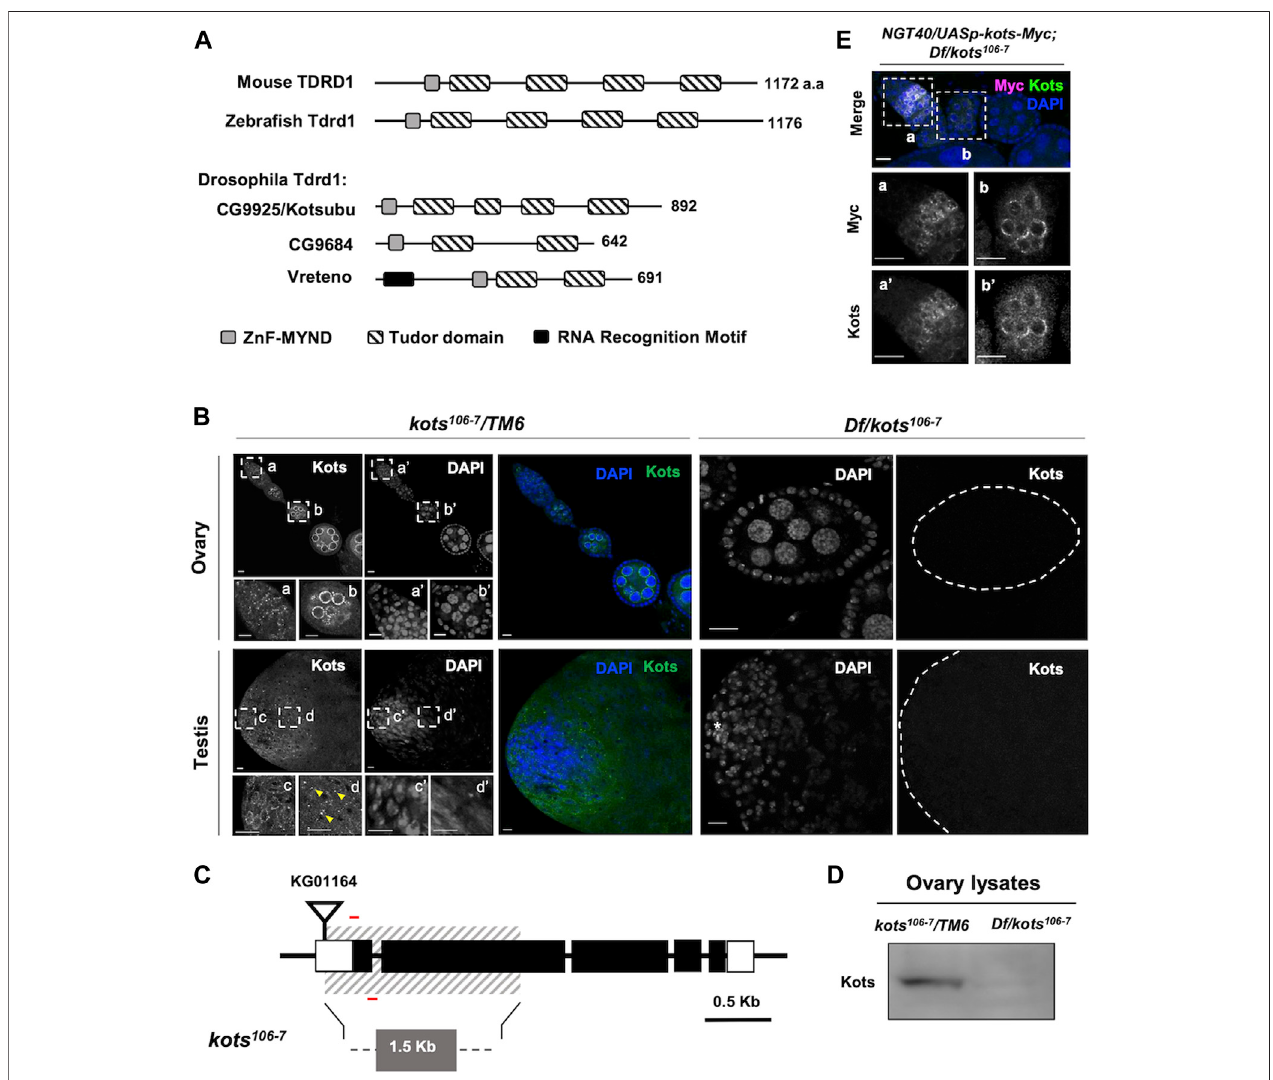
FIGURE1| Drosophila CG9925/Kotsubulocalizestothenuclearperipheryingermlinecells. (A) StructuraldiagramdepictingproteindomainsofTdrd1orthologsin mice, zebra fi sh, and fl ies. MYND-type zinc fi nger domain and Tudor domains are in light gray and stripes, respectively. In fl y, an additional N-terminal RNA recognition motif(black)isfoundinVretenobutisabsentintheotherorthologousproteins. (B) Kotsisobservedasperinuclearfociingermlinecellsinthegermaria(a)andlocalizesto the nuclear peripheral nuage in the egg chambers (b) in ovaries. In testes, Kots appears as perinuclear foci in the spermatogonia (c) and condenses into enlarged foci(yellowarrowheads)inthespermatocytes (d).EndogenousKotsisabsentinde fi ciency(Df)over kots mutantgonads (Df/kots 106-7 ) . (C) Loss-of-functionalleleof kots wasgenerated by imprecise excision ofaP-element insertion, KG01164 . Red bars represent theprimers used todetect 118bp ofthe fi rst exon. (D) Western blottingof ovarian lysates showing a single band for Kots in the heterozygous control that is absent in Df/ kots 106-7 mutants. (E) Immunostaining of kots mutant ovaries expressing C-terminalMyc-taggedKots(Kots-Myc)ingermlinecellswithanti-MycandKotsantibodies. NGT40 wasusedtodrivetheexpressionofUASp -kots-Myc inthegermline. Perinuclear puncta in the germaria (a, a ’ ) and egg chambers (b, b ’ ) are discernible. All scale bars are 10 μ m.